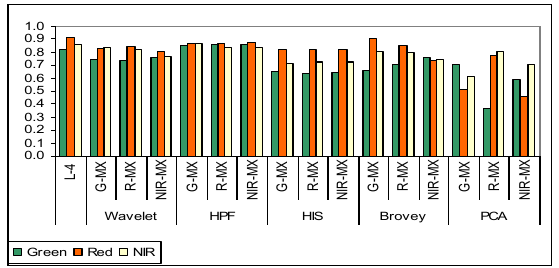
Fig-3: Correlation coefficient (CC) of L-3 with L-4 and merged images